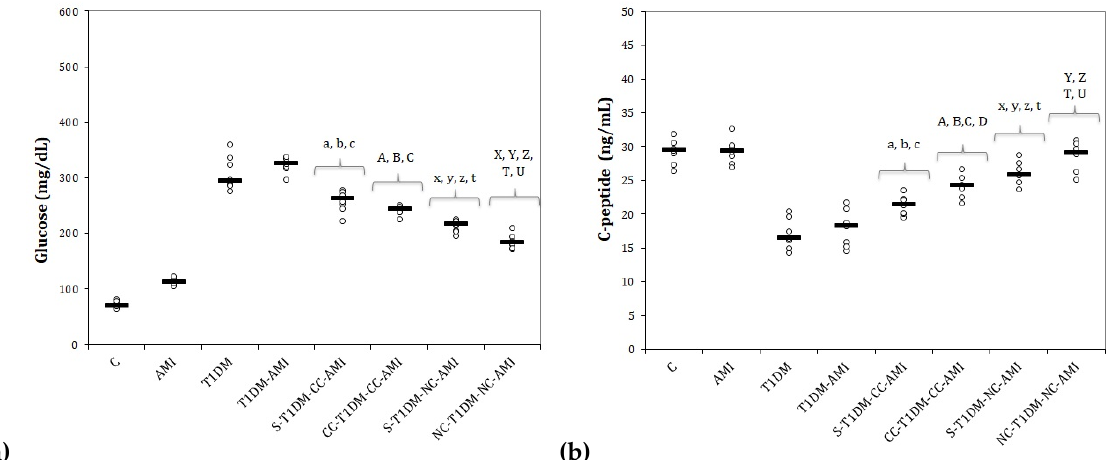
Figure 2. Serum blood glucose and C-peptide levels: ( a ) glucose; ( b ) C-peptide. C—control; AMI—acute myocardial infarction; T1DM—type 1 diabetes mellitus; S—saline (0.09%); CC—conventional curcumin solution (200 mg/Kg bw); NC—solution of curcumin nanoparticles (200 mg / Kg bw). The letters correspond to p values <0.05: (a) S-T1DM-CC-AMI compared to AMI; (b) S-T1DM-CC-AMI compared to T1DM; (c) S-T1DM-CC-AMI compared to T1DM-AMI; (A) CC-T1DM-CC-AMI compared to AMI; (B) CC-T1DM-CC-AMI compared to T1DM; (C) CC-T1DM-CC-AMI